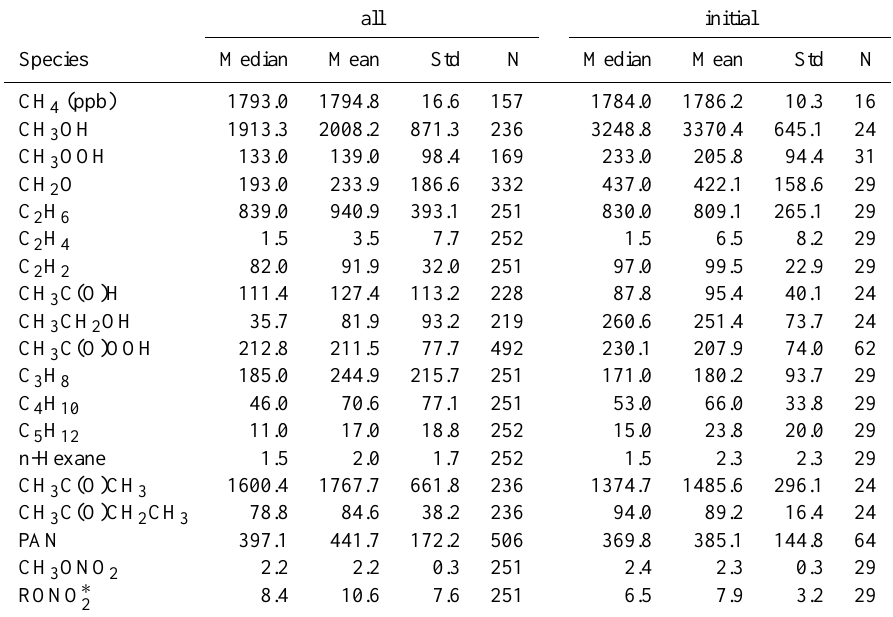
Table A2. Summary of organic observations, from 8 to 10km, used for evaluation (all) and for initialization (initial) from the INTEX-A observational campaign. Unless otherwise noted values, are in parts per trillion